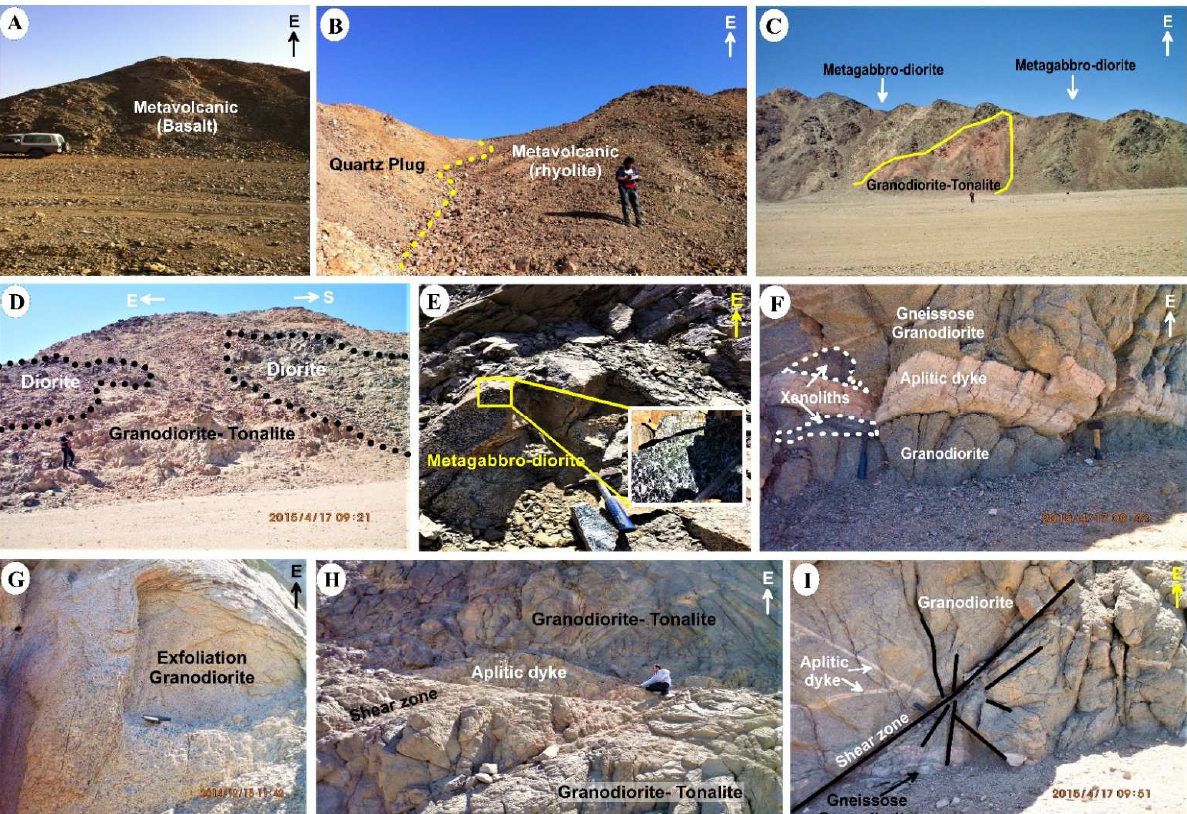
Figure 3. Field photographs of the of Abu–Ghalaga area show: ( A ) moderate—hills of metavolcanics blocks (metabasalts). ( B ) Contact between quartz plugs and metavolcanics (metarhyolites). ( C ) and